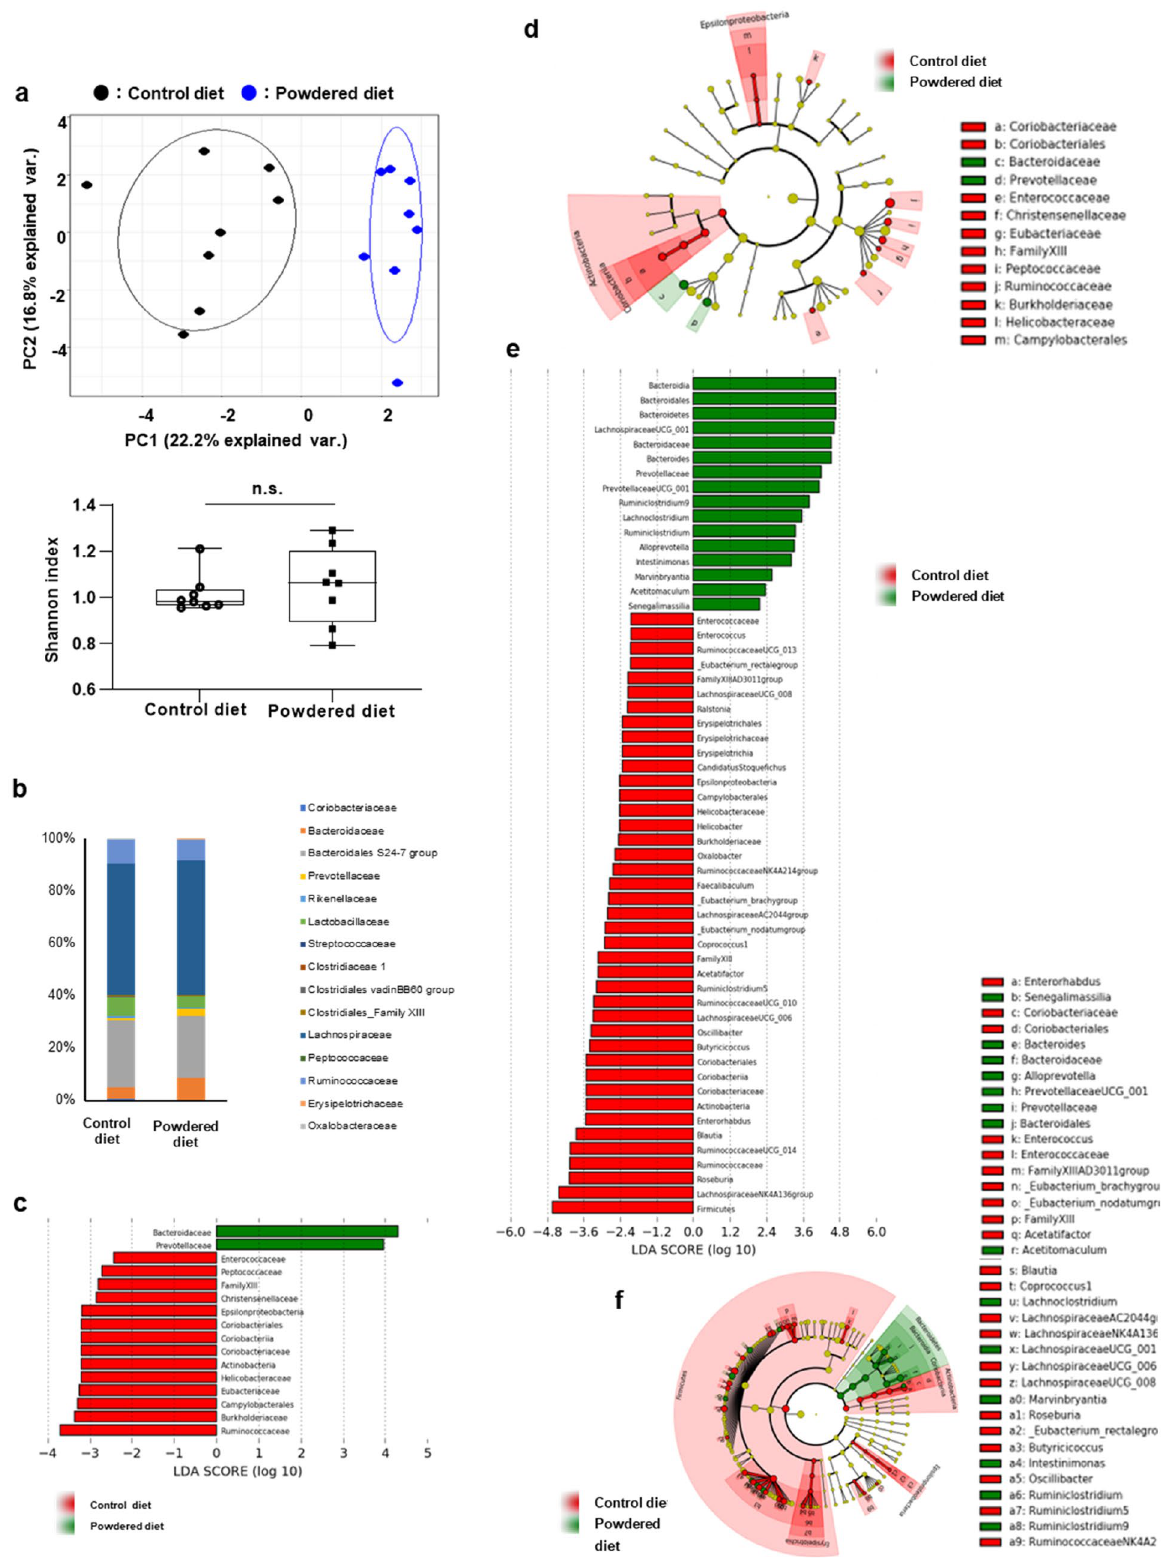
Figure 3. Effects of long-term powdered diet feeding on the cecal microbiota in mice starved for 5 h. ( a ) Cecal microbiota compositions determined as their beta diversity as shown via principal component analysis (PCA) at the family level (p = 0.004). There was no difference between the groups in alpha diversity. PERMANOVA was used to determine statistical significance. ( b ) Relative abundance of major taxonomic groups at the family level. ( c ) Bar chart and ( d ) cladogram of results of linear discriminant analysis (LDA) and effect size (LEfSe) algorithm of fecal microbiota at the family level. ( e ) Bar chart and ( f ) cladogram of results of LDA and LEfSe algorithm of fecal microbiota at the genus level. n = 8 per group. ( d ) and ( f ) were generated using the Huttenhower lab’s Galaxy module (http:// hutte nhower. sph. harva rd. edu/ galaxy/) for LEfSe